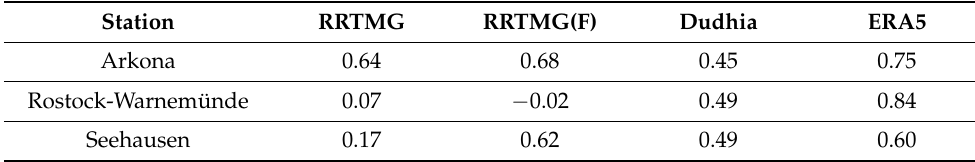
Table 5. Summary of correlation coefficients for cold fronts.